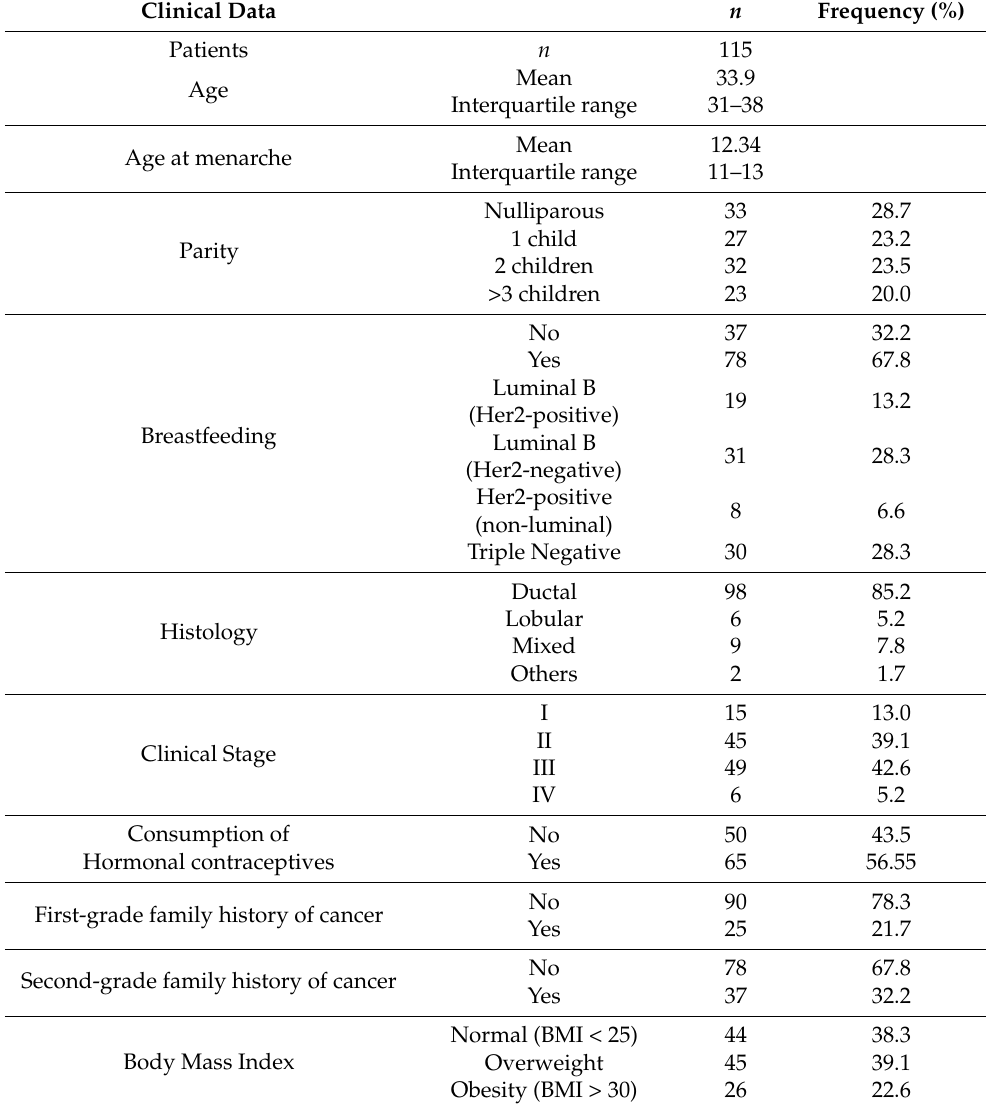
Table 1. Clinical data of 115 BC young